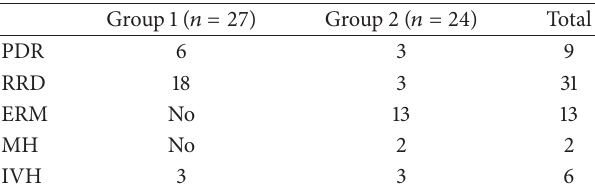
PDR: proliferative diabetic retinopathy; RRD: rhegmatogenous retinal detachment; ERM: epiretinal membrane; MH: macular hole; IVH: intravit- real